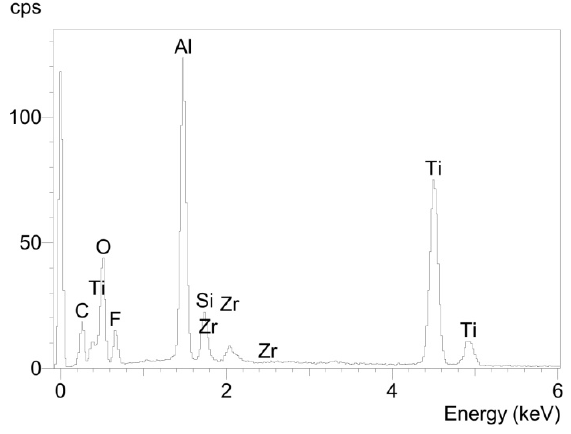
Figure 10. Elemental spectrum for sample 5_ATZ_Ti determined using EDX analysis.